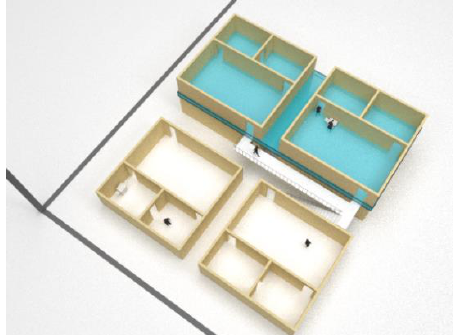
Figure 5. Area defines a generalised space or sub-space. In the figure the second floor represents an area. An Area is distinguishable from a Location in that and Area can be decomposed into